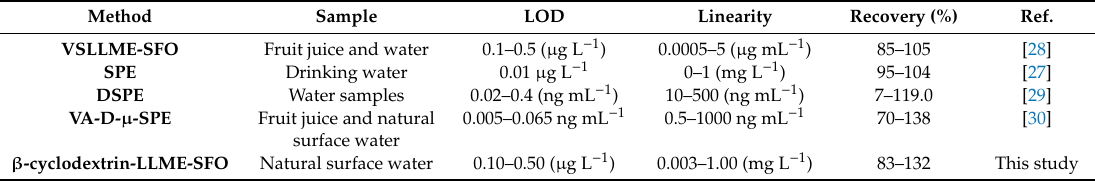
Table 3. Comparison of the proposed method and other methods to determine